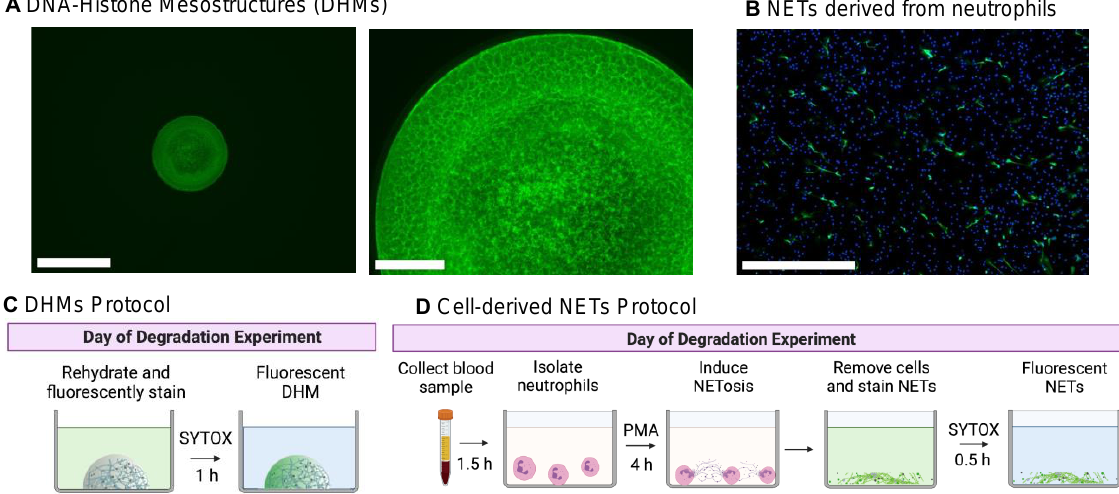
Figure 1. Initial structures of DNA – histone mesostructures (DHMs) and neutrophil extracellular traps (NETs) for degradation experiments. ( A ) One DHM micropatterned in each well of a 96-well microplate, single-well view (left) with a 650 μ m scale bar, and magnified view of the fibrous structure (right), with a 125 μ m scale bar. DHM structures were stained with SYTOX Green. ( B ) Fixed phorbol 12-myristate 13-acetate (PMA)-stimulated NETs as a visualization of the initial state before degradation experiments. NETs were stained with neutrophil elastase (NE; green), and neutrophils were detected with Hoechst 33342 (nuclear DNA, blue). We note that while NET visualization uti- lized NE, degradation experiments were quantified using SYTOX staining. The scale bar is 650 μ m. A comparison of protocols needed to prepare DHMs ( C ) and NETs ( D ) for degradation experiments. Schematics created with BioRender.com, created on 1 October 2022.